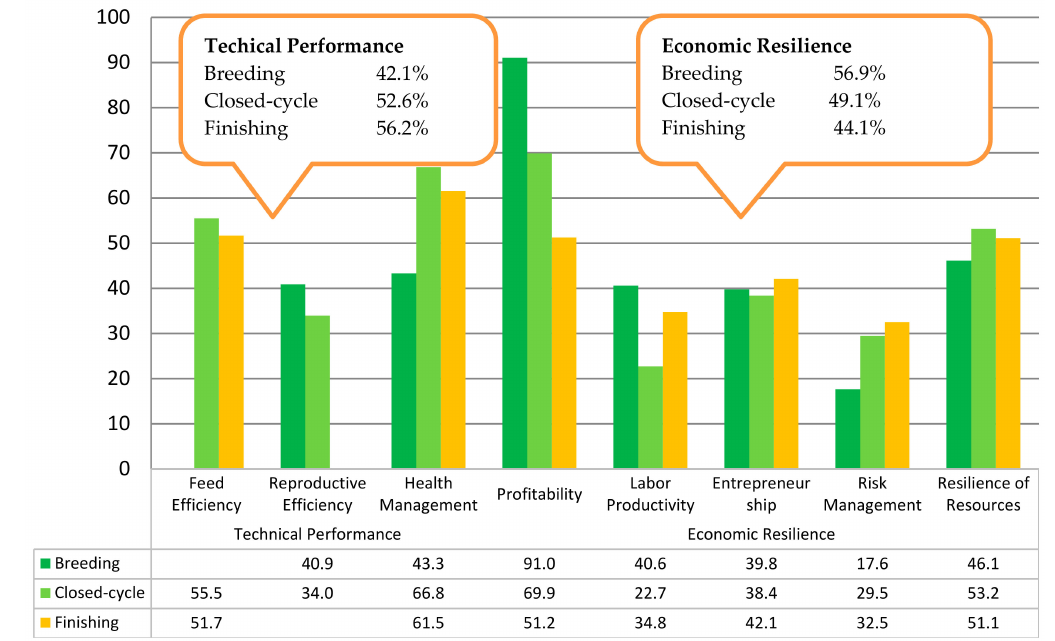
Figure 4. Results of the sustainability assessment of pig farms according to different subthemes and themes (weighted results). Note: results of scaled indicators were weighted in order to integrate results to the subtheme level. Source: Own calculations.